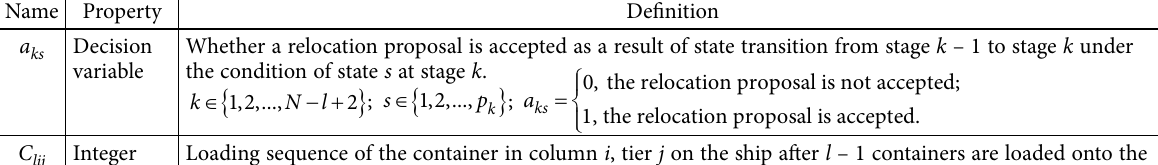
Table 2. Definitions of parameters and